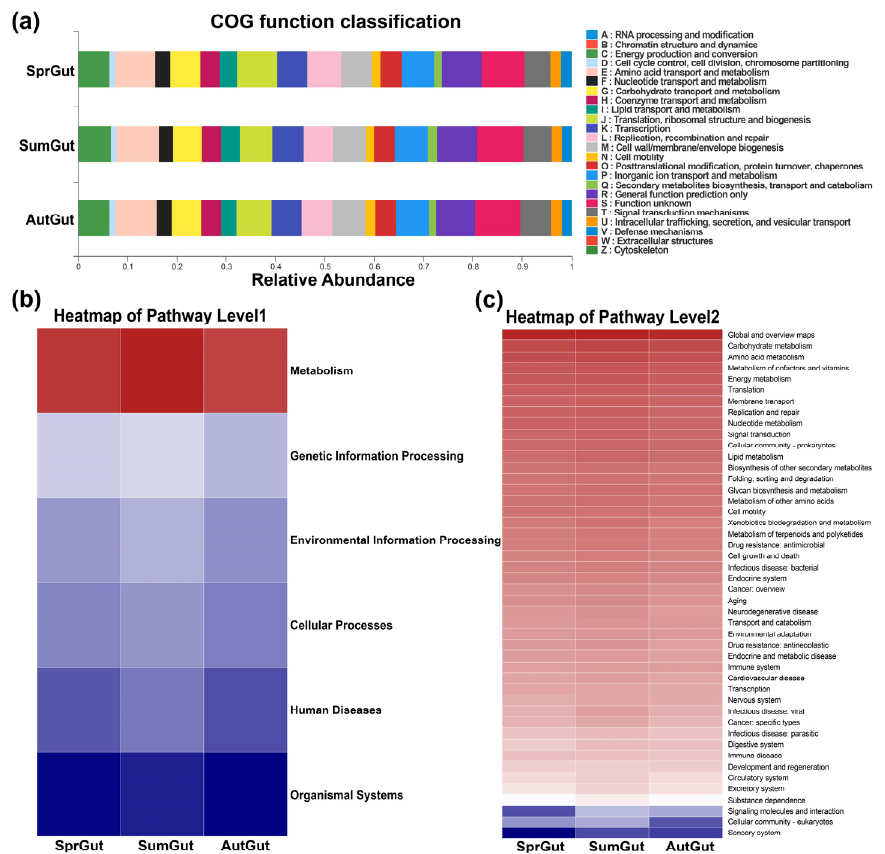
Figure 7. ( a ) Gut microbiota predicts metabolic functions from the EggNOG database. Relative abundance column diagram of microbiota functions based on the KEGG database. ( b ) Microbiota functions are shown on the fi rst level; ( c ) microbiota functions are shown on the second level. PICRUSt was used to predict the function of the gut microbiota. A total of 7237 KEGG